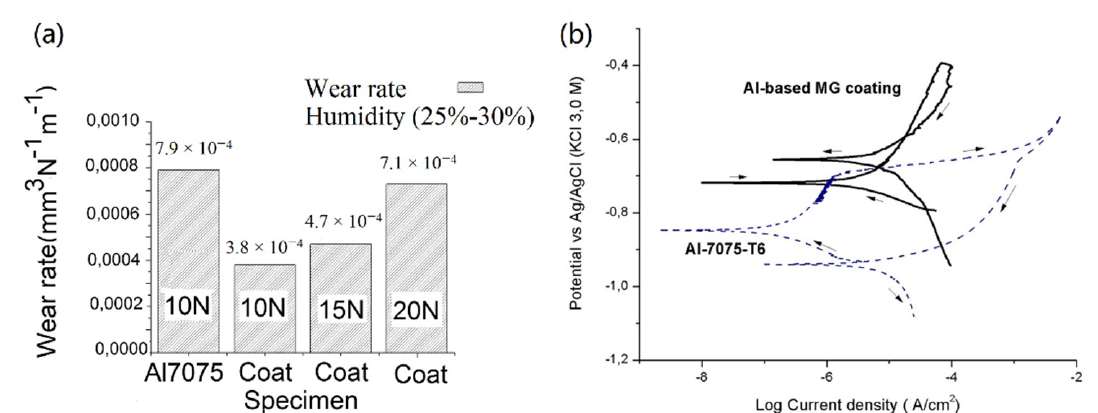
MG coatings and Al7075-T6 alloy in a 0.6 M (3.5%) NaCl solution. Obviously, Al-based MG coatings spontaneously passivated from the corrosion potential at about − 0.7 V up to at least − 0.4 V. Rather, the Al-7075-T6 alloy showed a corrosion potential more negative than − 0.8 V, while the pitting corrosion started at − 0.7 V.